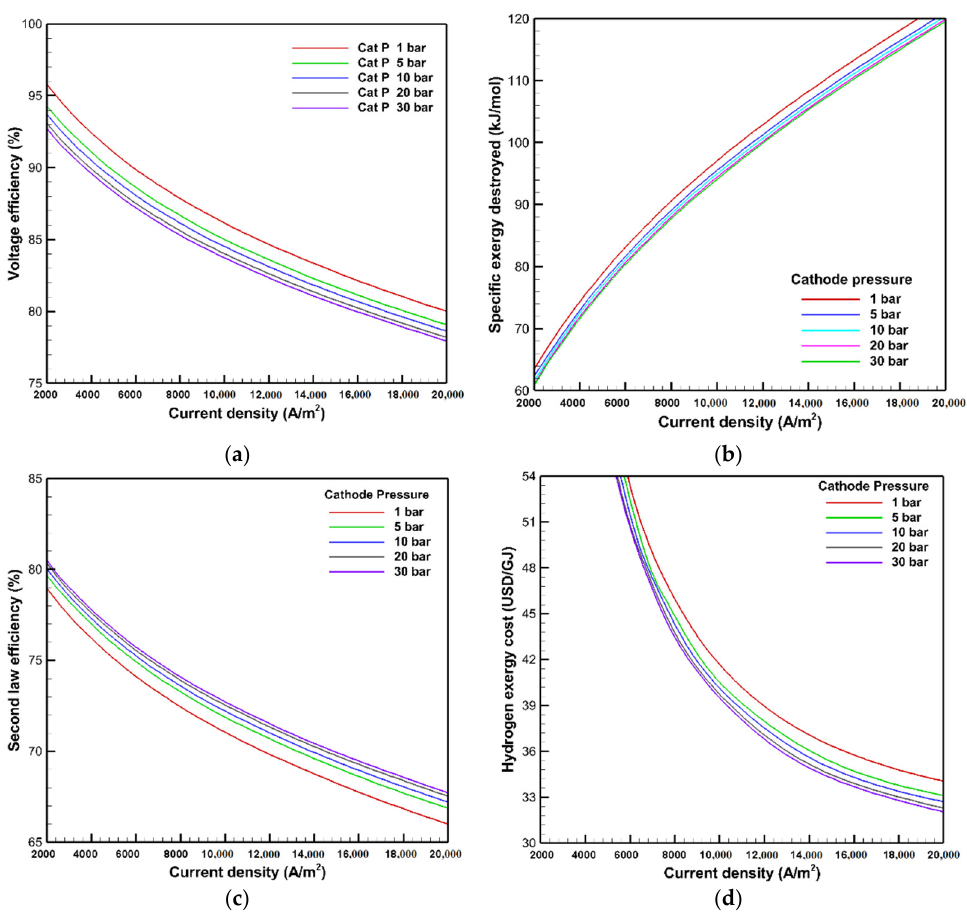
Figure 8. Effects of cathode pressure on: ( a ) voltage efficiency; ( b ) exergy destroyed; ( c ) second law efficiency; and ( d ) hydrogen exergy cost.